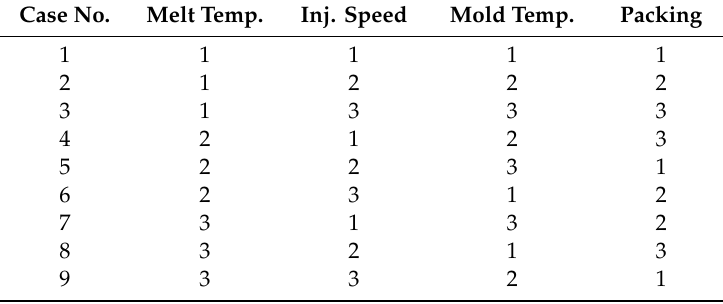
Table 4. Taguchi L9 (3 4 ) orthogonal array for design of experiments (DOE) of patterned and patternless LGP. Case No. Melt temp. Inj. Speed